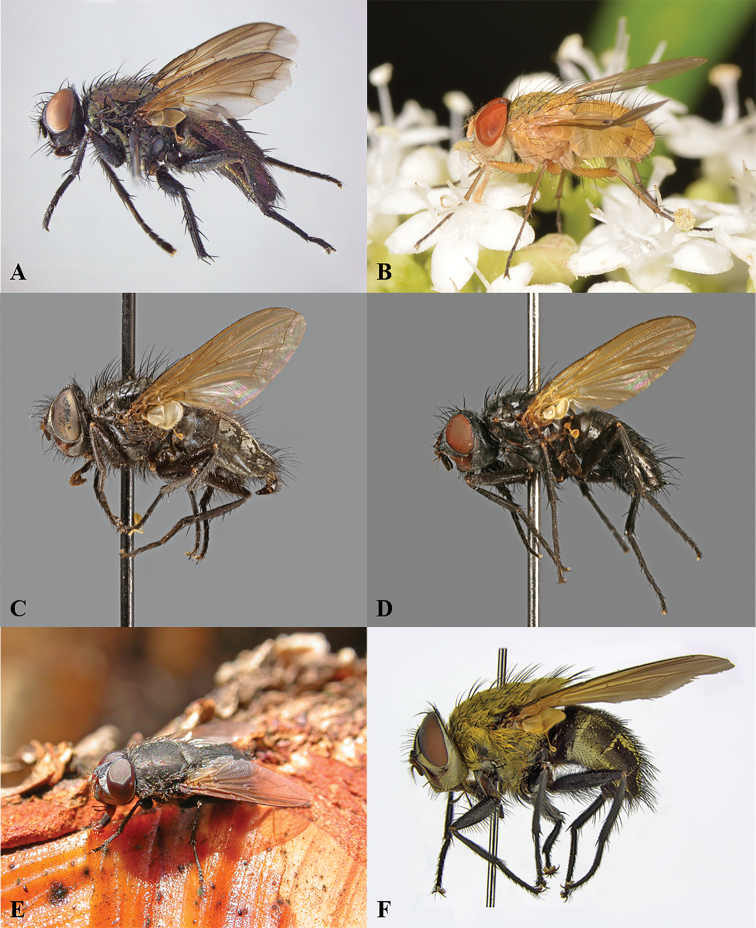
Representative species for all genera of Polleniidae. AAlvamaja
chlorometallica Rognes [Romania] BDexopollenia
cf.
flava (Aldrich) [Japan: Honshu] CMelanodexia
satanica Shannon [USA: California] DMorinia
tsitsikamma Cerretti et al. [South Africa] EPollenia sp. [Italy] FXanthotryxus
mongol Aldrich [China]. Photographs: Cerretti et al. (2019) (A), K. Oomori (B), P. Cerretti (E), K. Szpila (F).